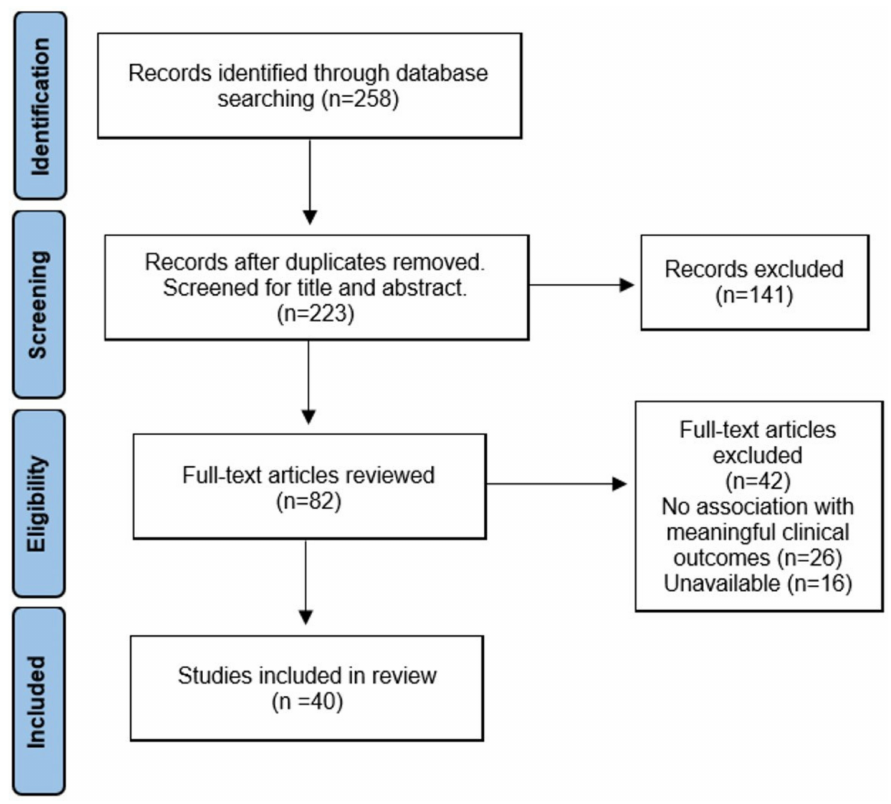
Figure 1. The preferred reporting items for systematic reviews and meta-analyses (PRISMA) flow